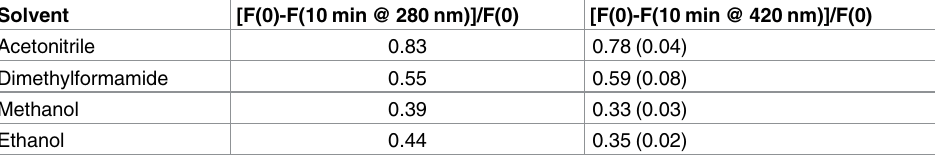
Table 8. Spectrofluorimetric assessmentof singlet oxygen generation by CURC and K2T23. Solvent Acetonitrile Dimethylformamide 0.55 Methanol 0.39 0.33 (0.03) Ethanol 0.44 0.35 (0.02) Fractional fluorescence decrease of 9,10-dimethylanthracene in 10:1 dimethylanthracene:CURC mixtures in the solvents indicated in column 1 upon illumination of the sample with light at 280 nm (column 2) and 420 nm (column 3) for 10 minutes (see text for details). The results in parenthesis in column 3 were obtained with K2T23 as the